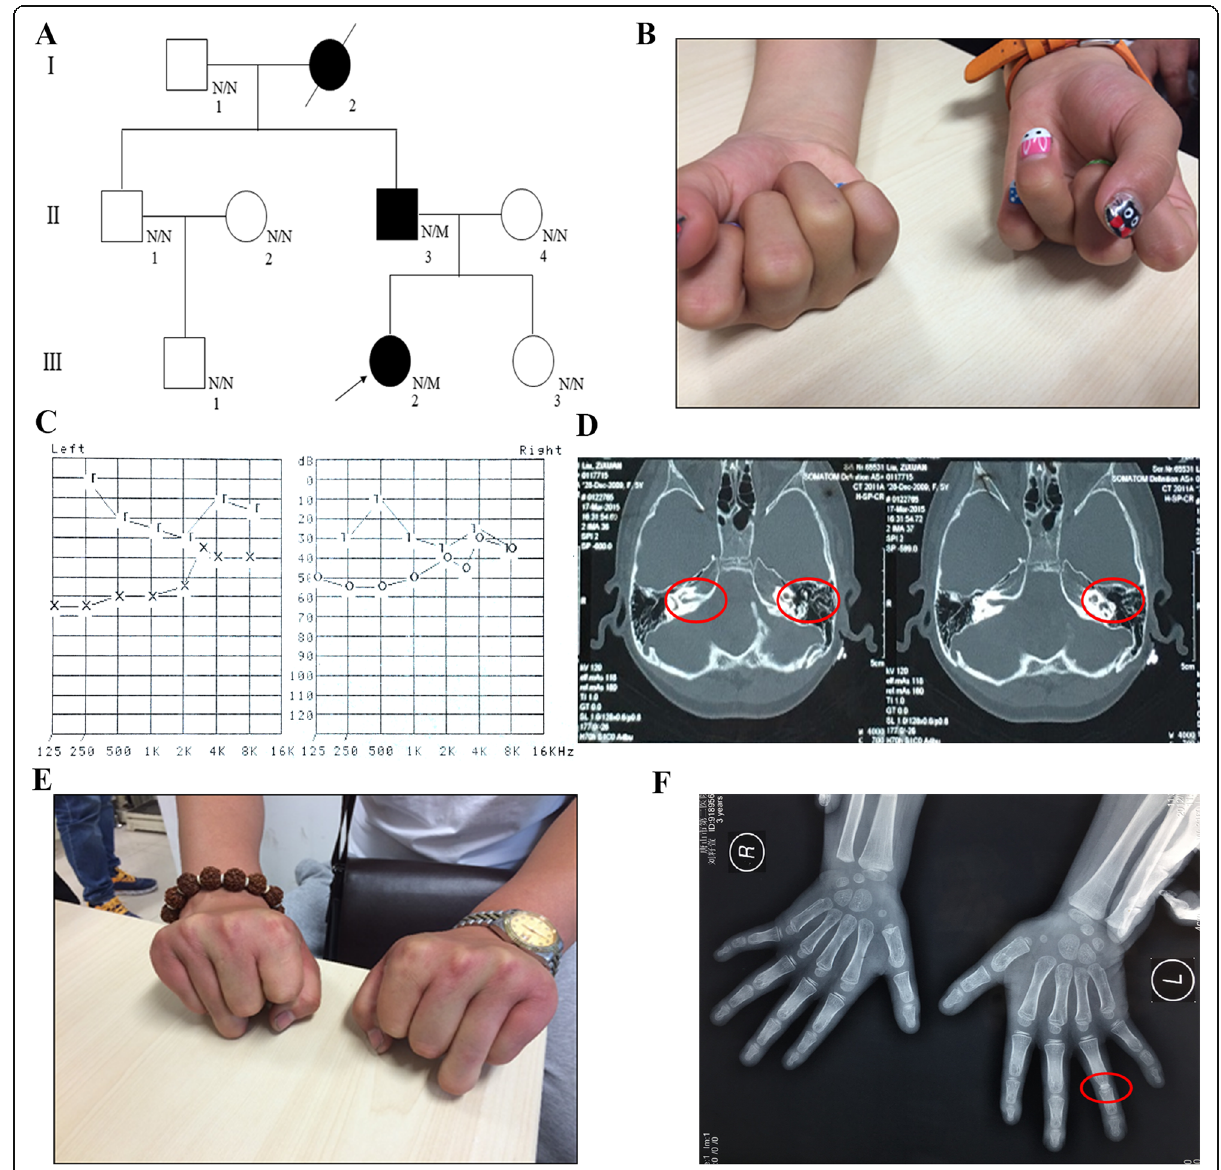
Fig. 1 The Clinical data of the family. a The pedigree of this family. Black circles/squares are affected, white circles/squares are unaffected. N means Normal, M indicates Mutation. Arrow indicates the proband. b The proband showed the symphalangism of the 4th finger in the left hand. c Hearing testing suggests the proband suffering from moderate deafness. d Inner ear CT showed abnormal inner ear structure and abnormal calcification. The red circles marked the abnormal regions which indicated cochlear hypoplasia, inner ear bone thickening and increased density. e The symphalangism of the 4th finger in II-3. f Hands X-ray of III-2. The red circles marked the abnormal